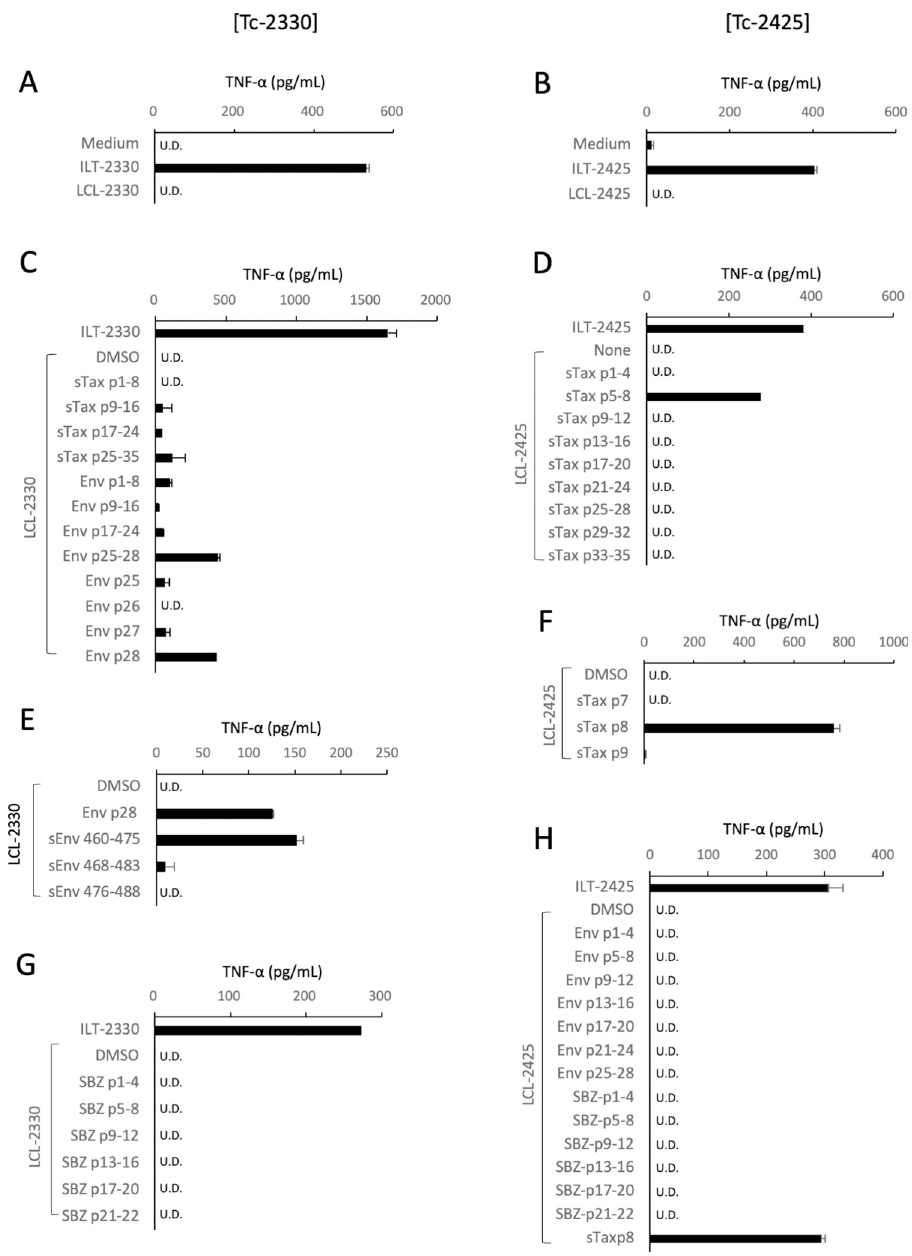
Fig 7. Recognition of STLV-1 Tax and Env epitopes by the STLV-1-specific CTLs derived from vaccinated monkeys. STLV-1-specific CTLs were induced from monkeys #2330 (Tc-2330, left) and #2425 (Tc-2425, right) after vaccination, and their specificity and target epitopes were analyzed. A, B. Tc-2330 ( A ) and Tc-2425 ( B ) were co- cultured overnight with autologous ILT or LCL cells and the TNF- α concentrations in the supernatants were evaluated by ELISA. C–H . Tc-2330 ( C, E, G ) and Tc-2425 ( D, F, H ) were co-cultured overnight with autologous LCL cells that had been pulsed with 10 μ M of the indicated peptides beforehand, and then TNF- α levels in their supernatants were measured by ELISA. The peptides used were pooled or individual peptides of sTax and HTLV-1 Env (Env) ( C ), sTax ( D ), STLV-1 Env (sEnv) ( E ), sTax (F ), SBZ ( G ), or the Env and SBZ ( H ) regions. The values represent the mean and SD of duplicate samples except for the screening assays shown in D and G that were performed with single samples. U. D., undetectable. The amino acid sequences of the peptides used are listed in S2, S3 and S4 Tables.